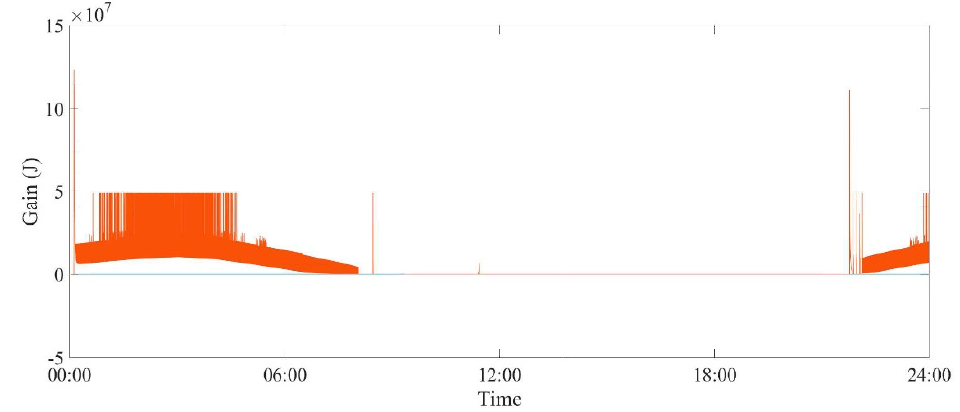
Figure 14. Energy use by Comb at a normal condition.